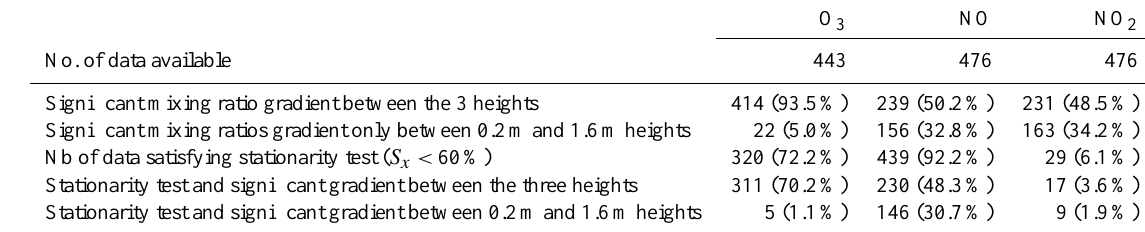
Table 3. Number of data available with significant mixing ratio gradients between the three measurement levels (i.e., 0.2m 0.7m and 1.6m), with significant mixing ratio gradients only between the highest and lowest measurement height (i.e., 0.2m and 1.6m), and satisfying the stationarity test for O 3 , NO and NO 2 . The number of data satisfying both stationarity test and having significant mixing ratio gradients are also given. The percentage of data kept are indicated in brackets. The significance of mixing ratio gradients was established using Student’s t-tests at the 95% confidence interval.